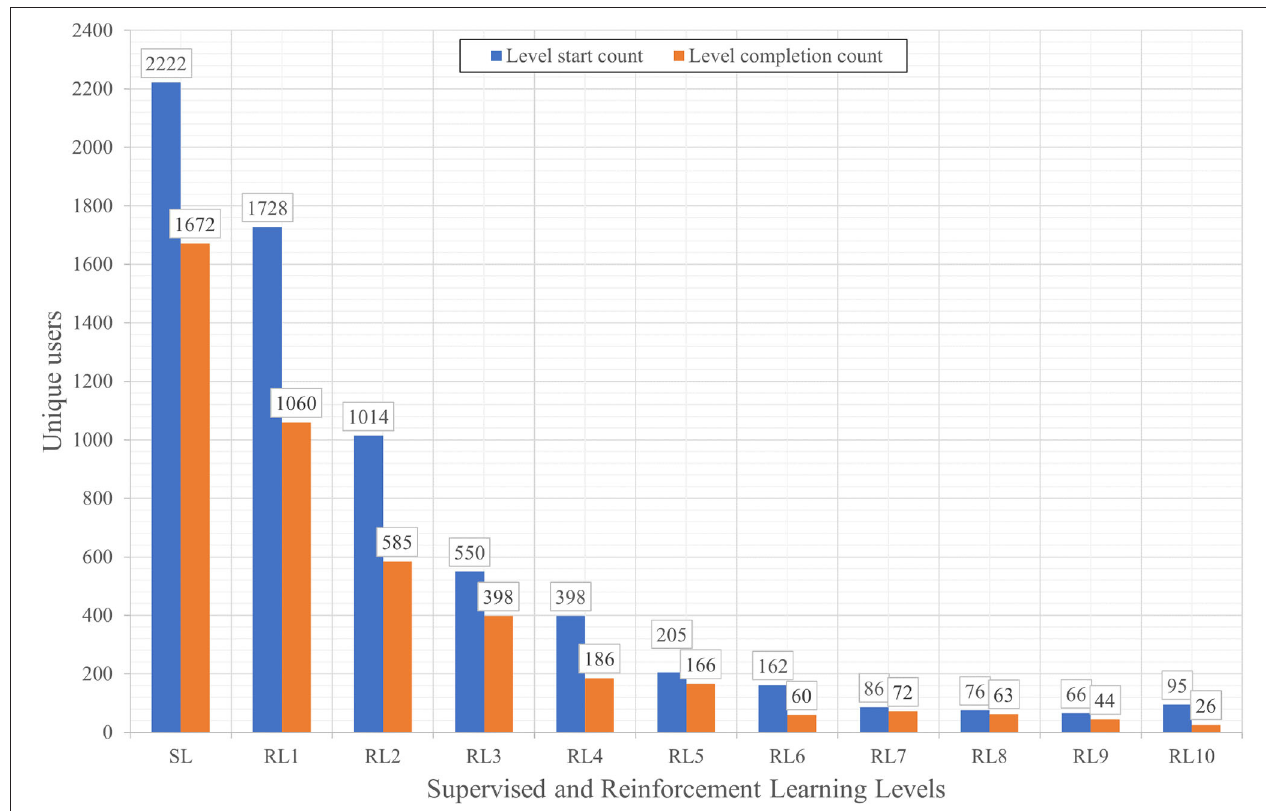
FIGURE 3 | Total number of unique users starting and completing the Supervised Learning level and the Reinforcement Learning